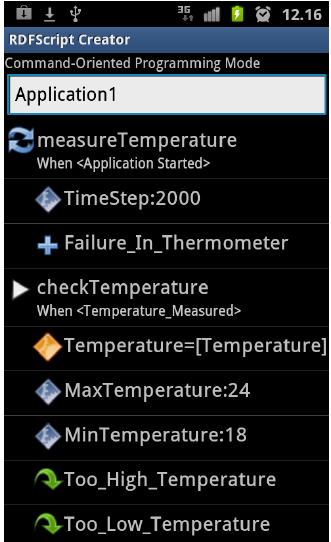
Figure 8. The end-user programming is performed in the list view of the RDFScript